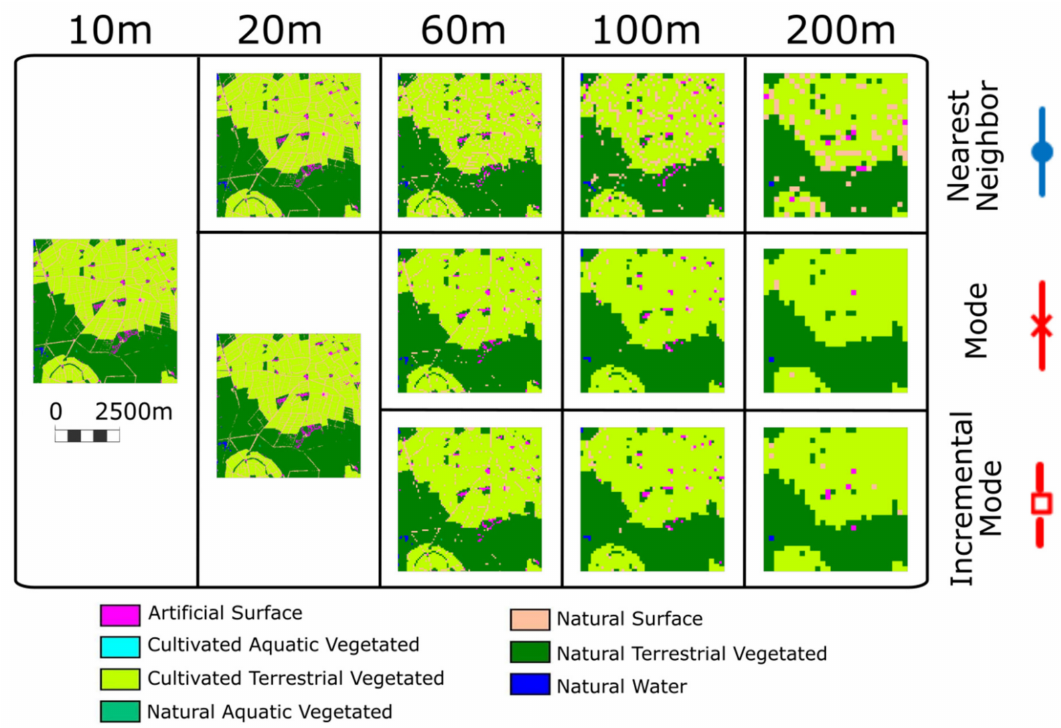
Figure 2. Detail of generalized land cover maps at several spatial resolutions (in columns) of the Camargue protected area obtained using three resampling methods (in rows). Despite the change in resolution, all the maps are presented at the same scale for visual comparison and use the same